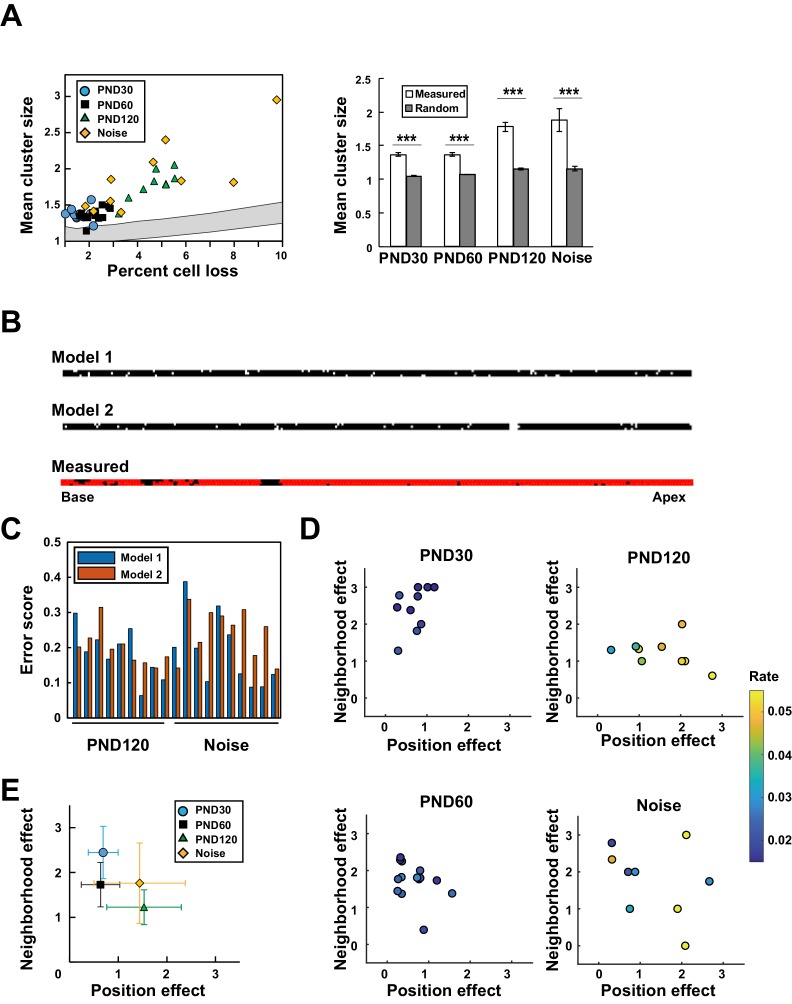
Model-based analysis of clustered cell loss.(A) Evaluation of the extent of clustered cell loss by comparison with the extent of clustering based on a model of random cell loss. The extent of cell clustering in the experimental data was much higher than would have been expected from random cell loss (99% confidence intervals within two lines) (Welch’s t-test, ***p < 0.001). (B) Construction of two models of hair cell loss (upper: neighborhood effect model; lower: position effect model). Virtual cell loss data were generated from the models and compared with the experimental data (measured). (C) Evaluation of the goodness-of-fit of the two models to the experimental data using the error score, which measures the extent of deviation of the clustering properties generated by the models from those observed in real samples. (D) Assessment of the relative contributions of the two models (neighborhood effect and position effect) to achieve the best fit to the experimental data. The two models contribute differentially under various conditions. The color code shows the proportion of lost OHCs against the total OHCs. (E) Overall pattern of contribution from two models. Note that the neighborhood effect makes a stronger contribution in young adult mice, whereas the position effect makes a stronger contribution in aged mice (means ± SD). Number of samples; n = 10 (PND 30), 14 (PND 60), 9 (PND 120), and 10 (Noise). PND, postnatal day.10.7554/eLife.40946.018Figure 4—source data 1.Source data for Figure 4A, C, D and E.